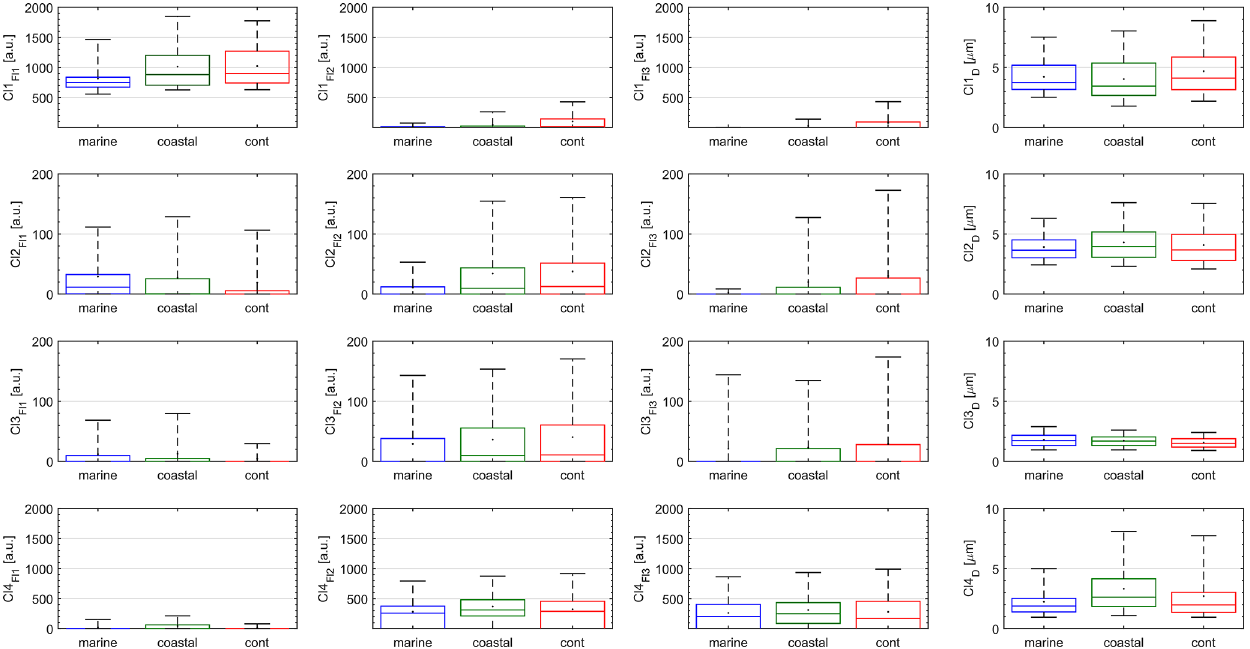
Figure 5. Mean fluorescence and size properties for each cluster, depending on the pathway of the previous 120h trajectory. Each region (ma- rine, coastal and continental) have taken 1 week’s worth of data, from 20/04/2016 to 26/04/2016, 20/06/2016 to 27/06/2016 and 25/01/2016 to 31/01/2016, respectively. Columns represent Fl channels 1–3, with the final column representing size in